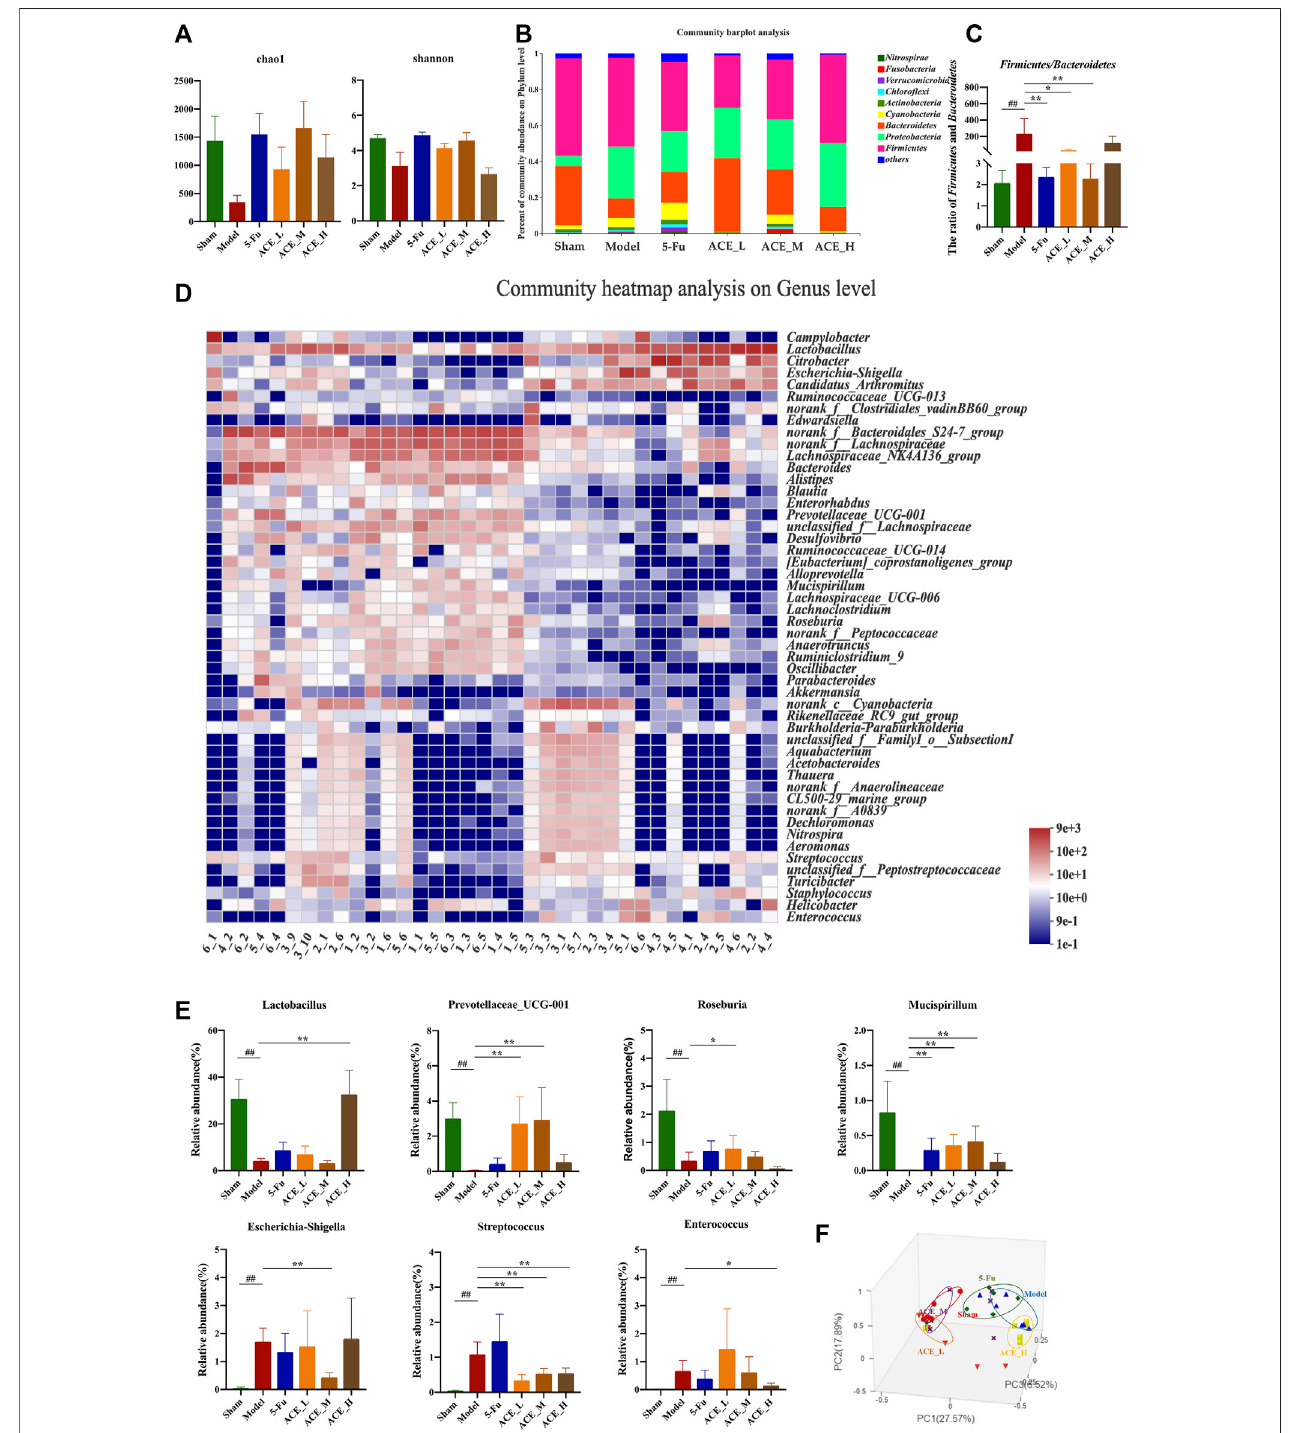
FIGURE4| Theeffectof Astragalusmongholicus Bunge- Curcumaaromatica Salisb.extractonthegutmicrobiotaofcoloncancer-bearingmice. (A) Alphadiversity index analysis (Chao and Shannon indices); (B) Community bar plot analysisof gut microbiota at the phylumlevel; (C) The ratio of relative abundances ofFirmicutes and Bacteroidetes; (D) Community heatmap analysis at thegenus level; (E) Representativedifferentiated genera; (F) PCoA analysisof gutmicrobiota. ## p < 0.01, compared with the sham group; * p < 0.05 and ** p < 0.01, compared with the model group. n (cid:2) 6.